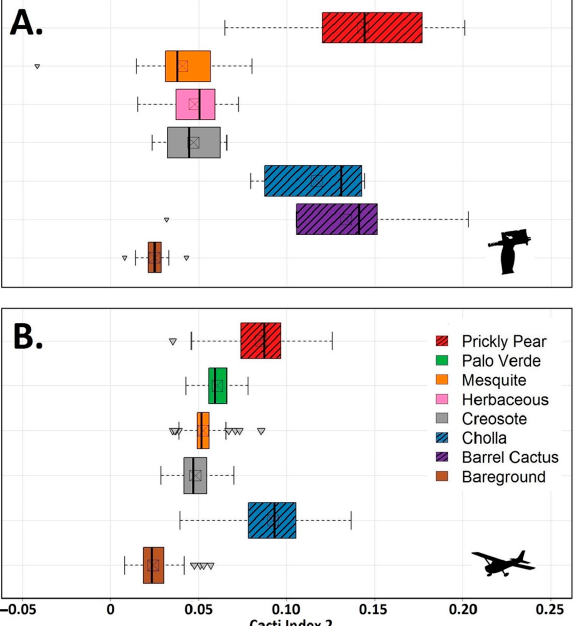
Figure 4. This graph shows the range of Cacti Index 2 (972 and 1072 nm) values for cacti, non- cacti vegetation, and bare ground computed from the Field Spectrometer ( A ) and NEON AVIRIS ( B ) collections. The red hatched boxes represent prickly pear, the blue hatched boxes represent cholla, and the purple hatched boxes represent barrel cactus. The square in the middle of each box is the mean for that series of samples. The whiskers represent the minimum and maximum values within the interquartile range. Any triangles outside the whiskers are outlier the NEON AVIRIS data we computed CI2. The calculated CI2 values for the selected pix ‐ els show a separation of the cholla and prickly pear (cacti) from non ‐ cacti vegetation and bare ground. The majority of values for the cholla samples range from 0.078 to 0.106, while